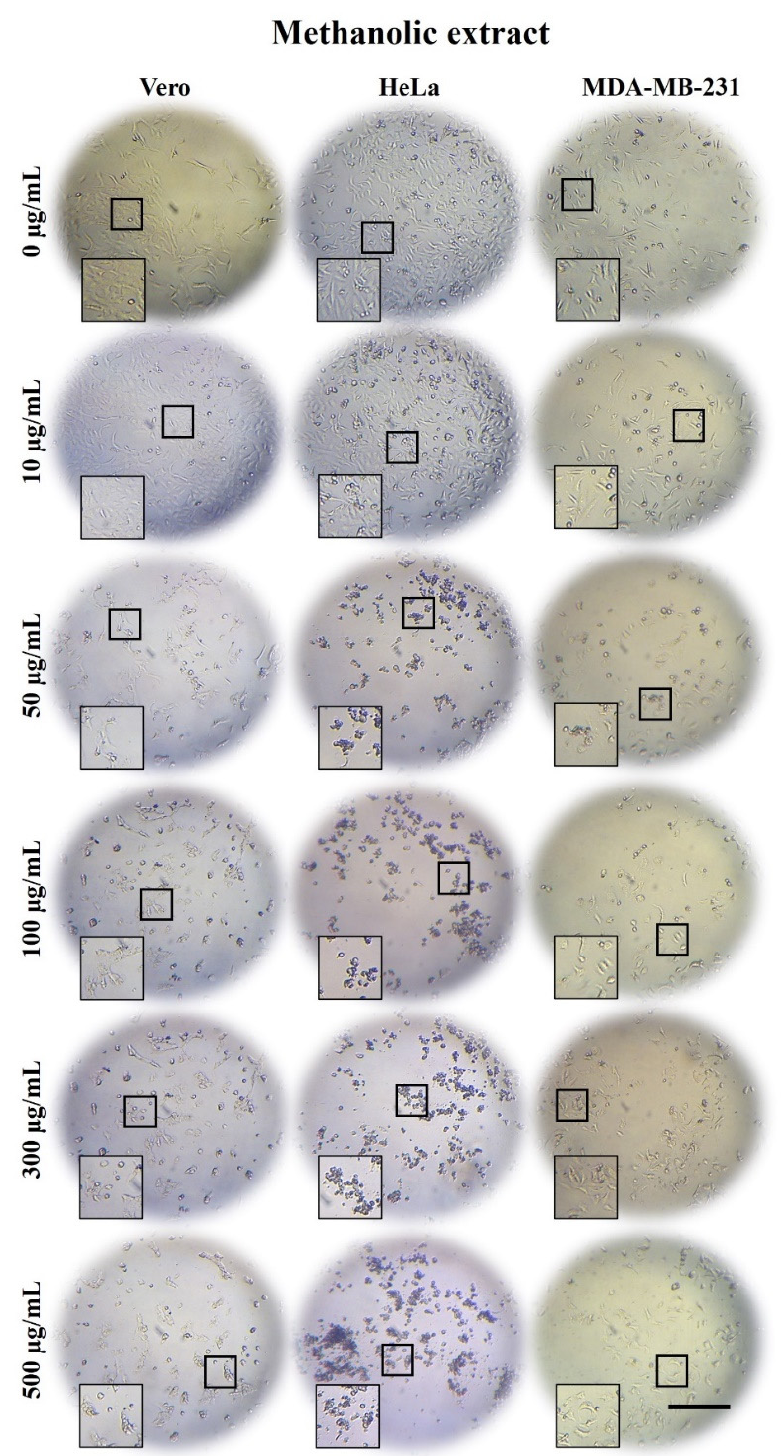
Figure 2. Micrographs of Vero, HeLa, and MDA-MB-231 cells exposed for 24 h to 0, 10, 50, 100, 300, and 500 µg/mL of A. monostachya ME. The tumor cells showed a marked decrease in confluence and morphological alterations as well as loss of adhesion after exposure to the extract. These changes were present from the concentrations of 50 µg/mL and higher. The HeLa cells showed more evident changes compared to Vero cells, which showed minimal changes, followed by the MDA-MB-231 cells. These alterations were time- and concentration-dependent. Scale bar = 200 µm.